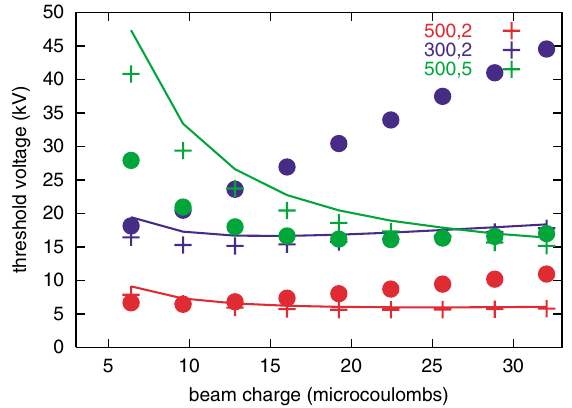
FIG. 17. (Color) Threshold voltage versus bunch charge for SNS with various values of equivalent bunch length (ns) and (cid:5) 3 . The crosses are the electron line density (nC = m), with Q r output of the eigenvalue code with M (cid:5) 5 and N (cid:5) 10 . The solid line is the coasting beam estimate using the M (cid:5) 5 tune distribution. The circles are the coasting beam estimate using a parabolic momentum distribution with the same rms width.